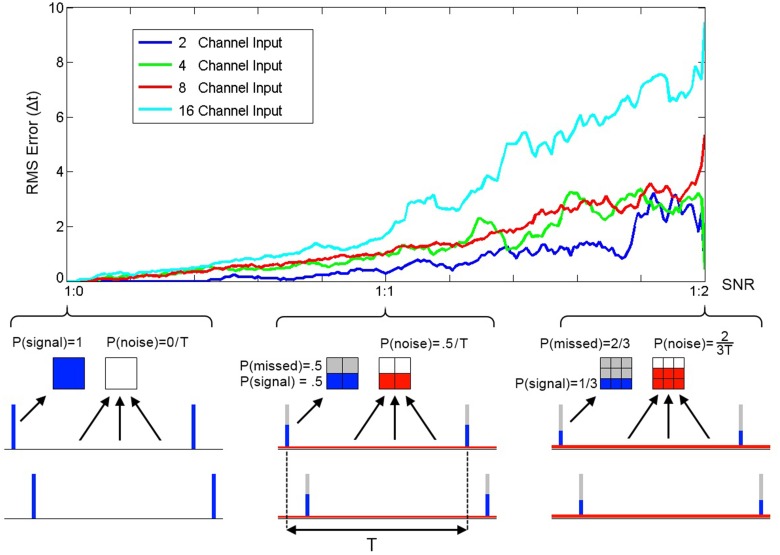
RMS error between receptive field maxima and target spike patterns as a function of spike signal to noise ratio. The three bottom panels show the spike probability distributions at three points along the SNR axis. The signal spikes (blue), missed spikes (gray), and noise spikes (red) are illustrated for the three cases of 1:0, 1:1, and 1:2 signal to noise ratios. The mean spike rate was maintained at 1 spike per channel per time period between pattern presentations T. At the completion of a simulation with one thousand pattern presentations the RMS error between the resulting receptive field maxima and the target spatio-temporal pattern was calculated. As the plot illustrates the error increases with noise and simulations of neurons with more input channels resulted in higher error.